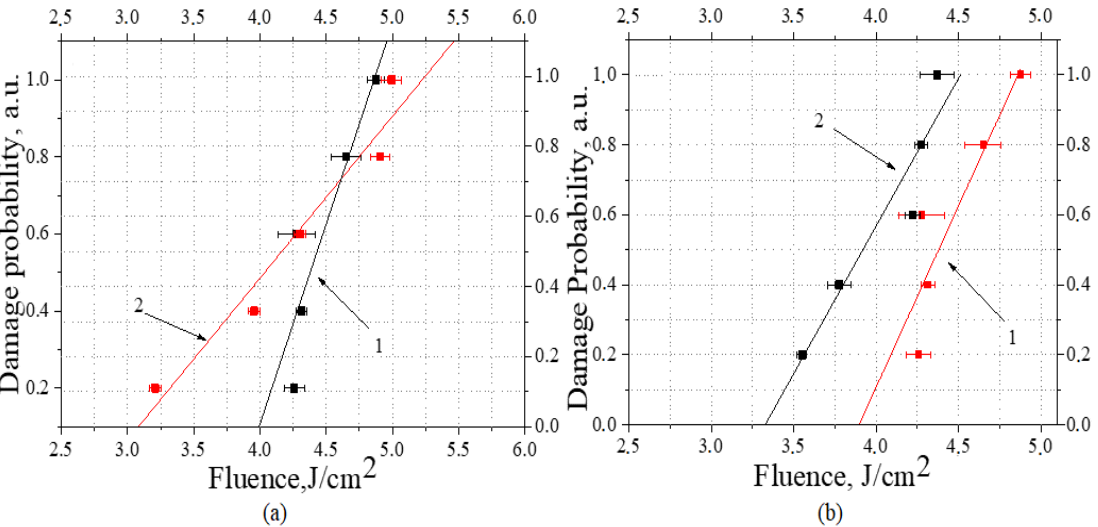
Figure 9. Damage probability vs fluence for Fe 2+ :ZnSe_Ar at the varied PRR of 12 kHz (1) or 16 kHz (2) at the constant exposure duration of 1 s ( a ), or at the varied exposure duration of 1 s (1) or 10 s (2) at the fixed PRR of 12 kHz ( b ).